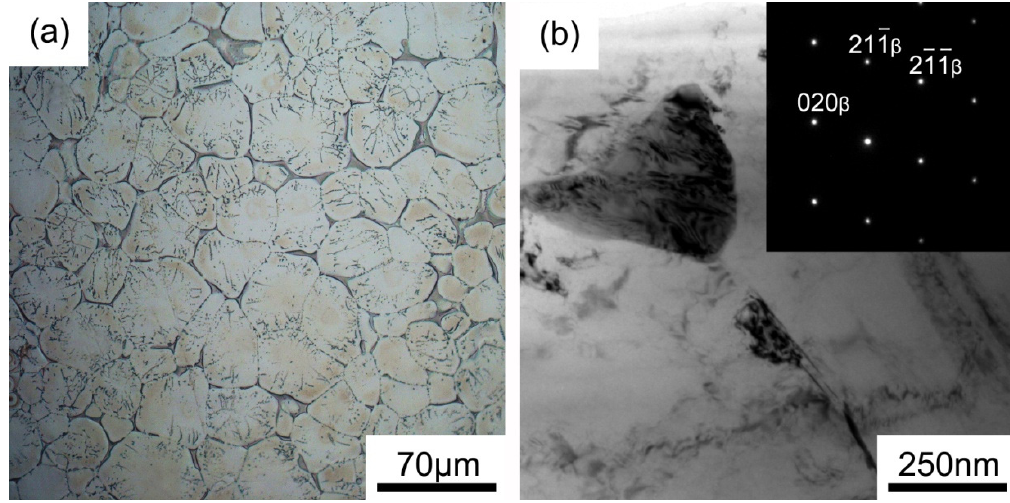
Figure 2. The microstructure of the as-cast specimen: ( a ) optical images and ( b ) TEM bright-field image and corresponding SAED patterns for β phase (B//[102] β ).